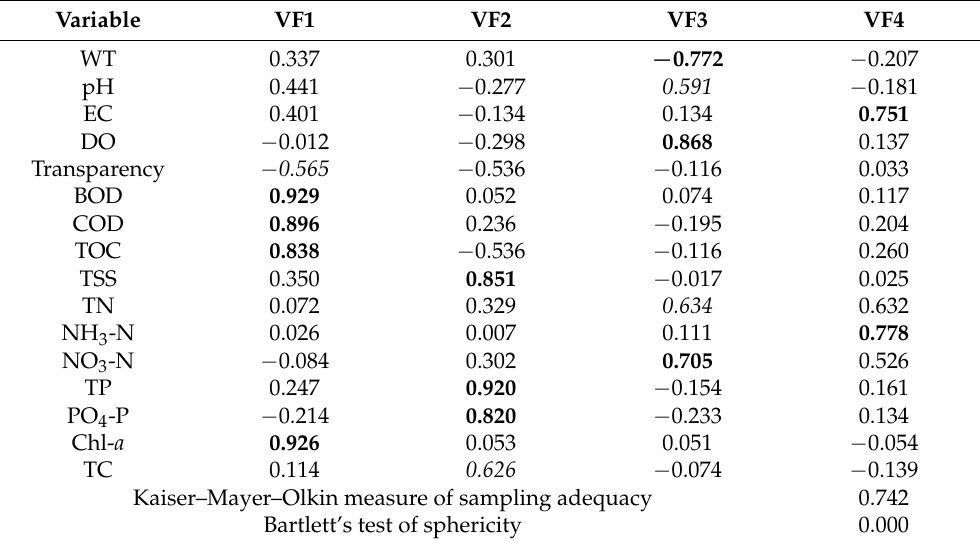
Table 5. Loading of the 15 experimental variables on significant principal components for the dataset.